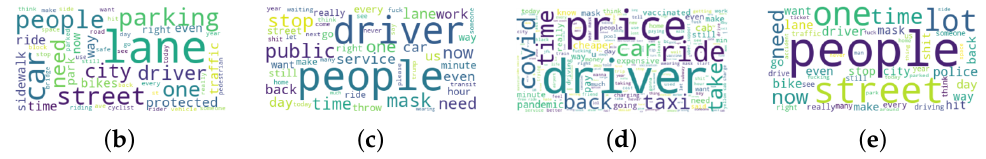
Figure 4. Wordmap. ( a ) Subway; ( b ) Bike; ( c ) Bus; ( d ) Taxi/Uber; ( e ) Private vehicle. From social media to real world. We look into red and blue lines in Figure 3. The number of tweets related to subway decreased drastically around mid-March 2020, which is consistent with the trend of subway usage. This is because when the stay-at-home order began (22 March 2020), people did not travel and the subway was mentioned less on social media. The subway usage shows an increasing trend starting from June 2020 because people started getting back to work at the reopening phase (9 June 2020). The number of tweets related to the subway and subway usage kept going up after April 2021. This is because an increasing number of people traveled after they got the first vaccination. Note that the number of tweets and the subway usage starts decreasing near the end of 2021. This is probably because many people were afraid of the Omicron variant (November 2021), and travel demand